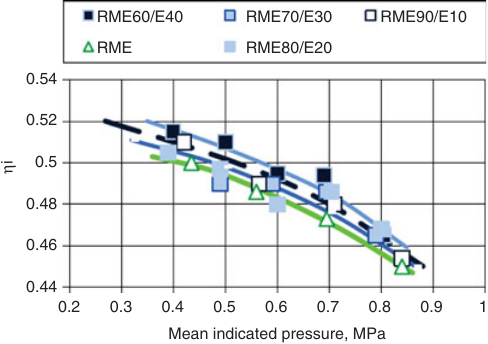
Fig. 3. Rise of 1A41 engine h i with increase in E component in RME (cid:2) E biodiesel